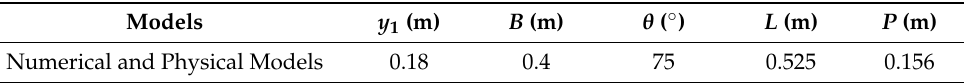
Table 1. Geometric characteristics of the triangular labyrinth side weir from Esmalili [22] and Kabiri Samani et al. [12].